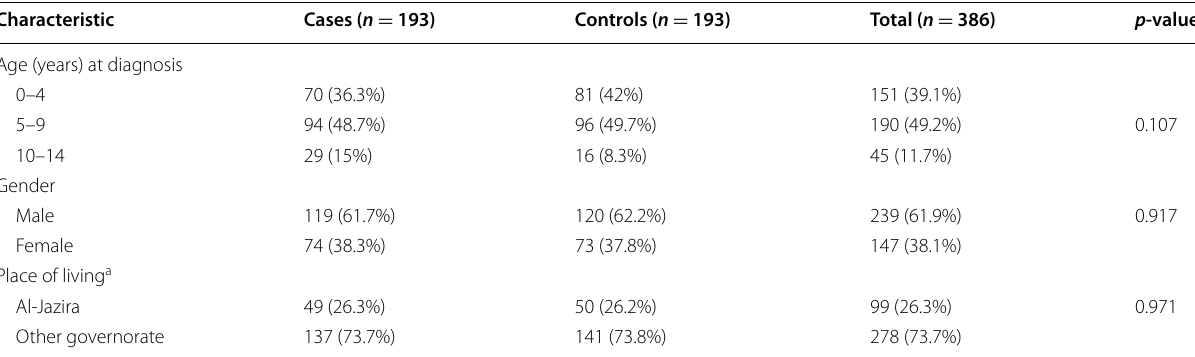
Table 1 Characteristics of children in case and control